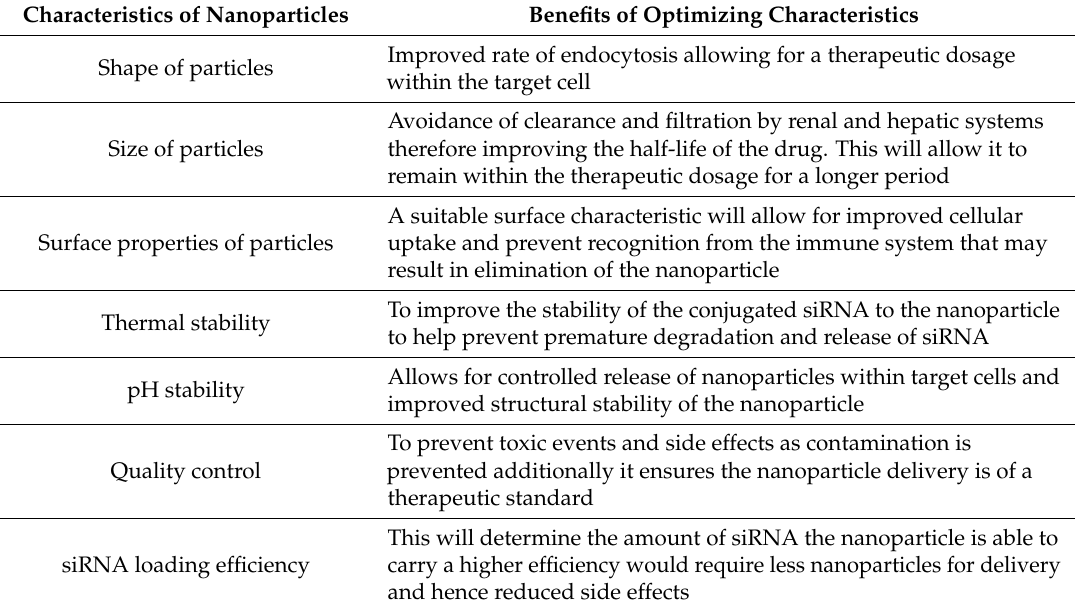
Table 2. Physicochemical characteristics of nanoparticulate delivery systems (Taken with permission from [1]. Copyright Elsevier,